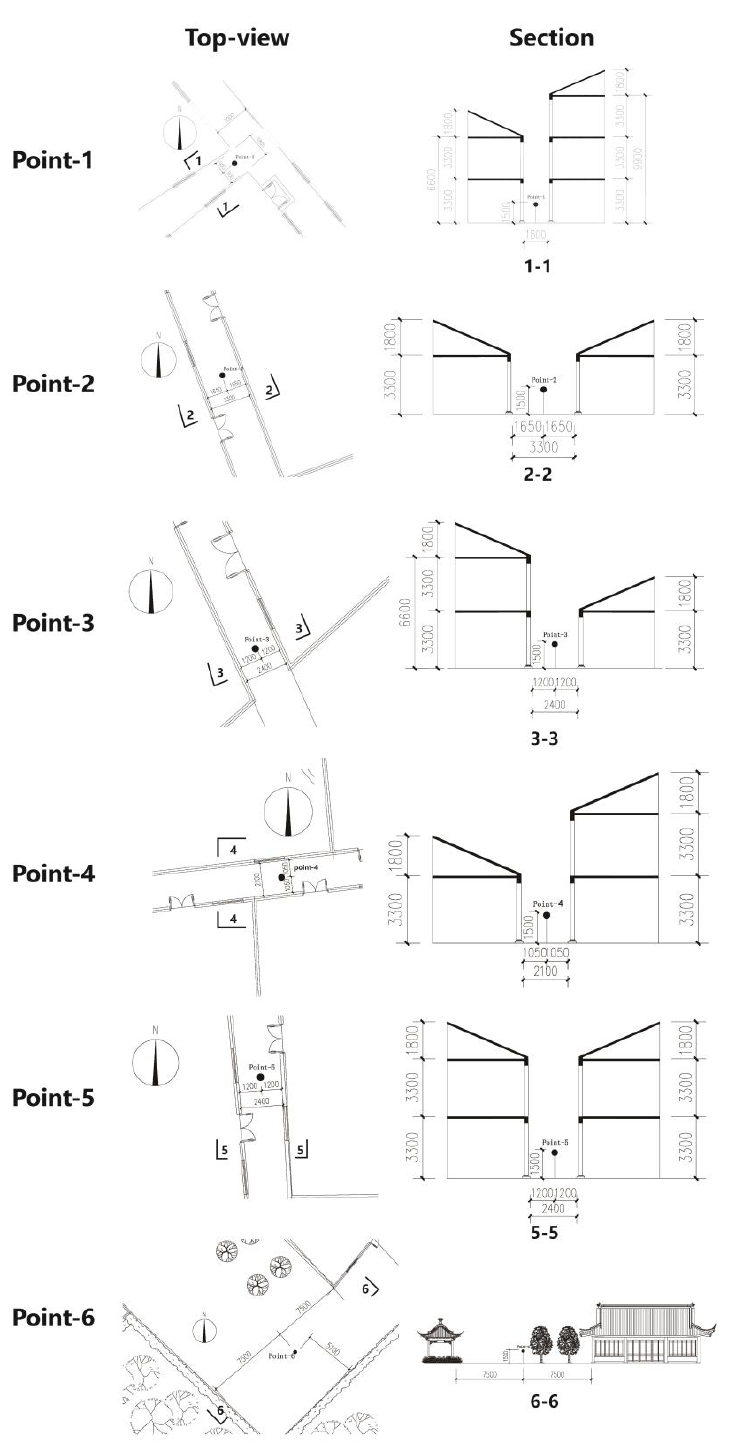
Figure 4. The plane and section of selected points [18].